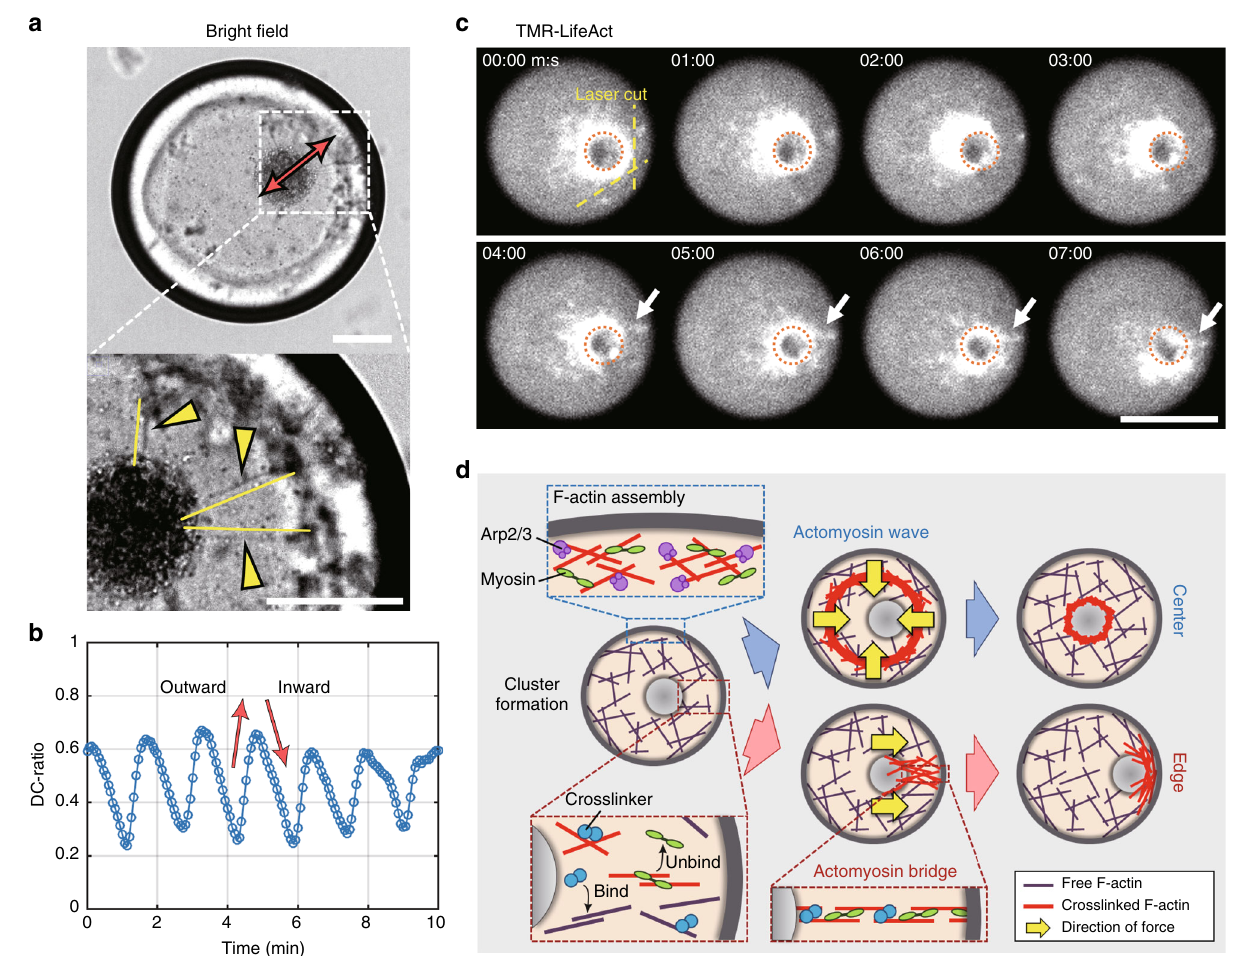
Fig. 4 Actomyosin bridges pull the cluster toward the droplet boundary. a , b Oscillatory motion of the cluster (Supplementary Movie 12). a Snapshot images of the droplet showing the oscillatory motion. (Top) The direction of motion of the cluster is indicated by the red double-sided arrow. (Bottom) The bridges connecting the cluster and the boundary are indicated by yellow arrow heads. b Time course of the cluster motion shown in a . c Actomyosin bridges formed between the cluster and the droplet boundary were cut by a UV pulsed laser. After the laser ablation, the cluster began to move back to the droplet center. After 4 min has passed, the cluster began to move to the edge again. In the same time, actomyosin bridges reassembled (white arrow). The original position of the cluster is indicated by the red broken circle (Supplementary Movie 14). d The tug-of-war model. (Top) Actomyosin waves push the cluster to the droplet center in every wave period. A magni fi ed view showing F-actin polymerization nucleated by the Arp2/3 complex. (Bottom) Between periodic actomyosin waves, if actomyosin bridges are formed, network contraction pulls the cluster to the edge. A magni fi ed view showing the dynamics of bulk actomyosin between periodic actomyosin waves. If inter-connected actomyosin bridges are formed between the cluster and the droplet boundary, the cluster is contracted toward the edge. Scale bars, 50 μ